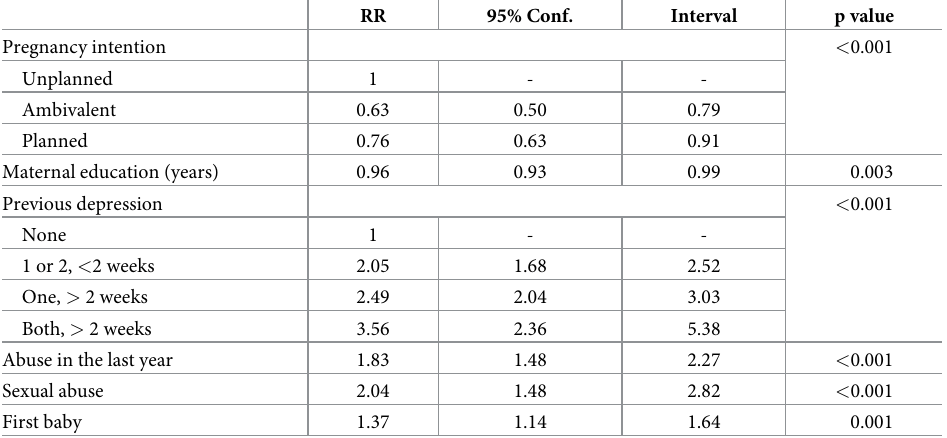
Table 5. Multivariable regression of pregnancy intention and high symptoms of depression.